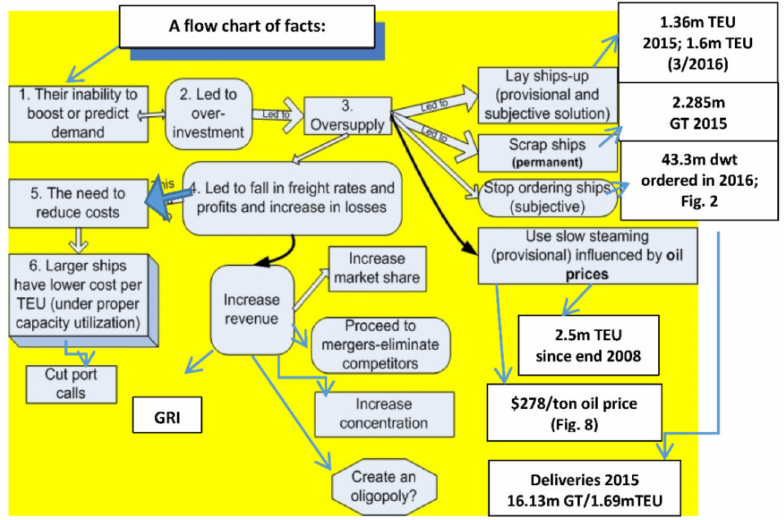
Figure 1. The Main Decisions taken by Carriers under end-2008 depression, 2009–2017. Source: